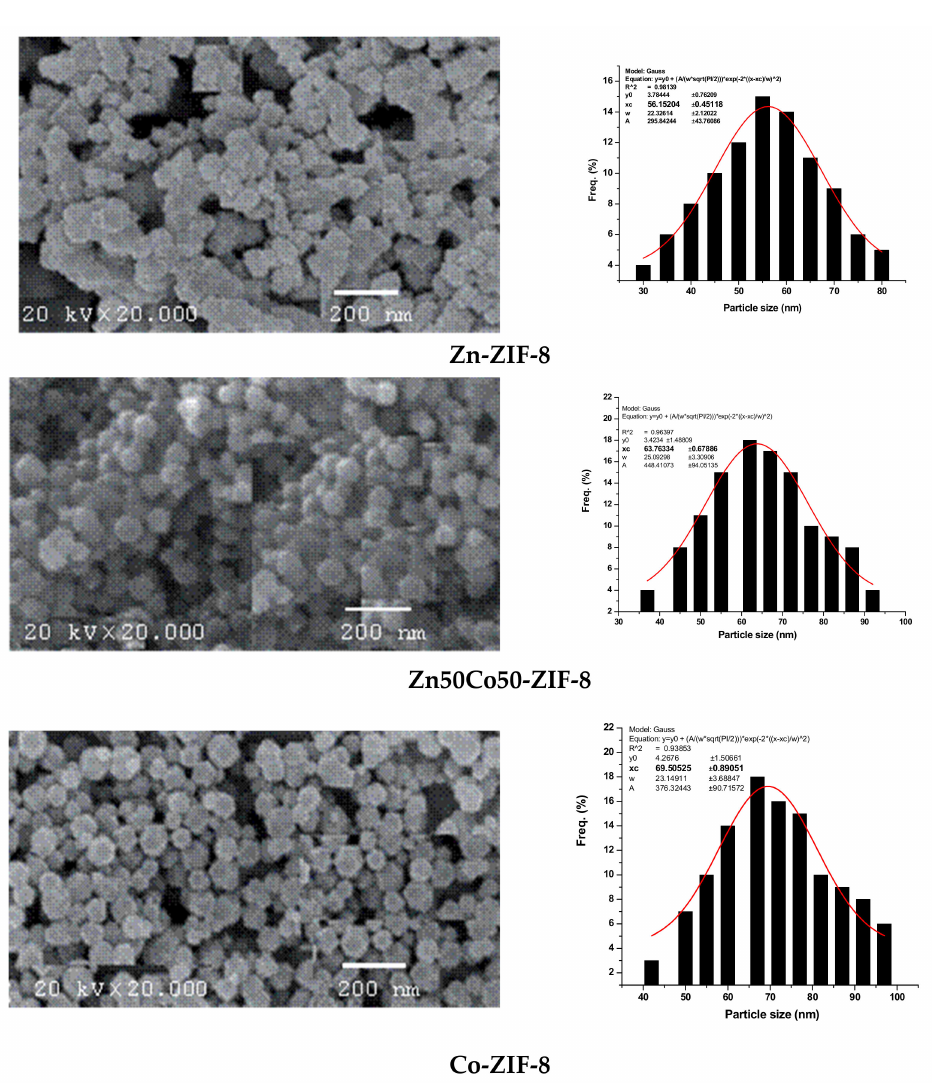
Figure 6. SEM images and histograms corresponding to Zn-ZIF-8, Co 50 Zn 50 -ZIF-8, and Co-ZIF-